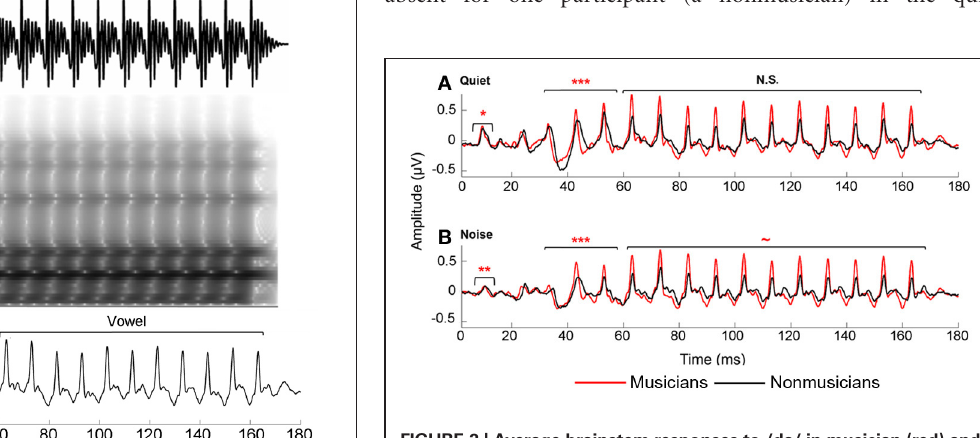
FIGURE 2 | Average brainstem responses to /da/ in musician (red) and nonmusician (black) middle-aged adults in quiet (A) and noise (B). In quiet, musicians had earlier neural response timing for the onset and transition portion; in noise, musicians had earlier neural responses for the onset and transition, with a marginally significant trend for the vowel. ∼ p < 0 . 1, ∗ p < 0 . 05, ∗∗ p < 0 . 01, ∗∗∗ p < 0 .